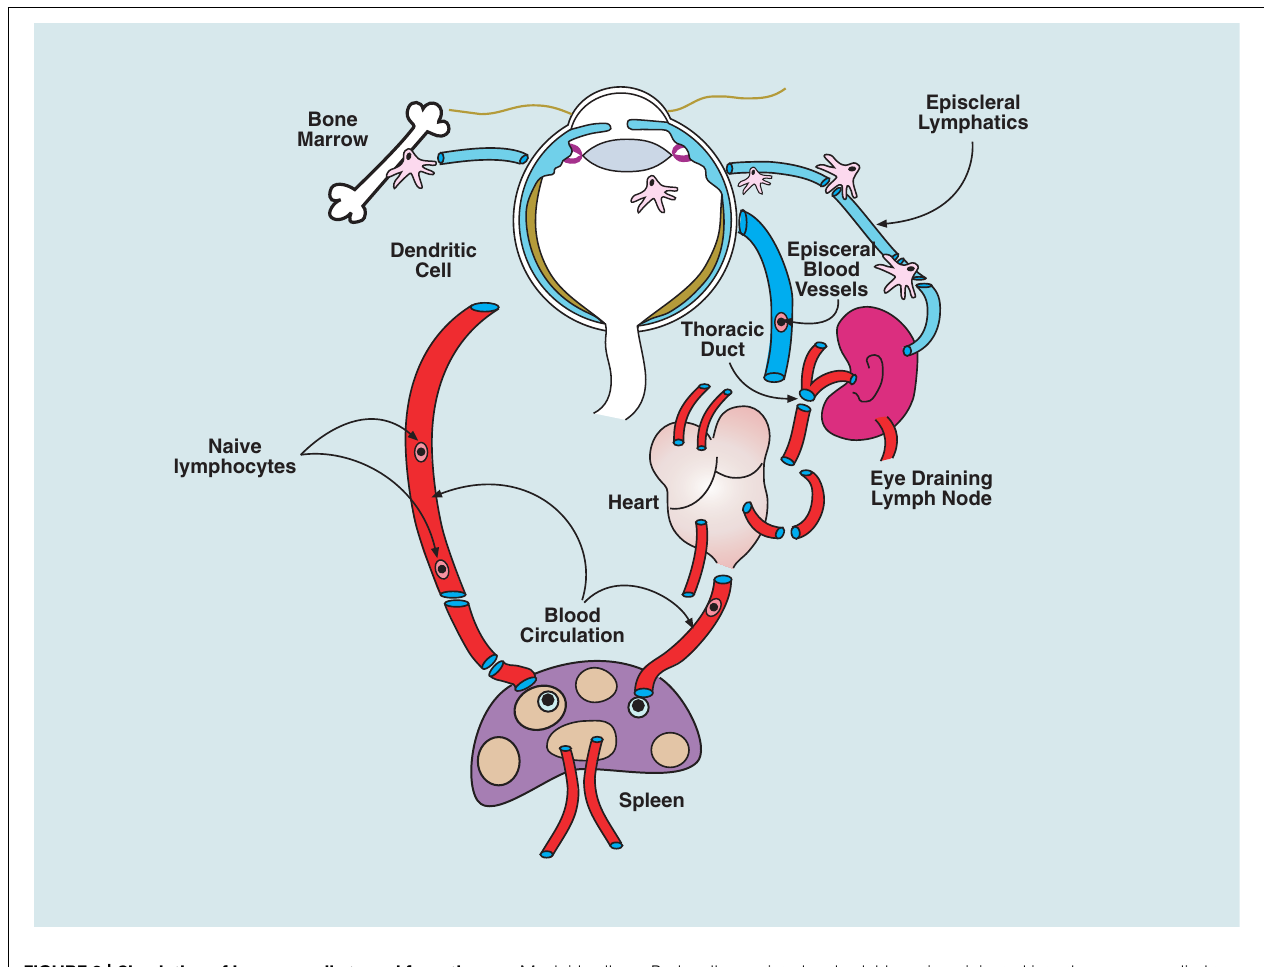
FIGURE 3 | Circulation of immune cells to and from the eye. Myeloid cells (macrophages and DCs) traffic from the bone marrow to the eye via the blood and populate some ocular tissues, predominantly the uvea (iris, ciliary body, and choroid); a few cells enter the peripheral retina and cornea.When ocular tissues are perturbed, bone marrow-derived cells, carrying antigen from the eye, can be found in the eye-draining lymph node (DLN; see text). However whether there is transport of steady-state antigen to the DLN is not known.